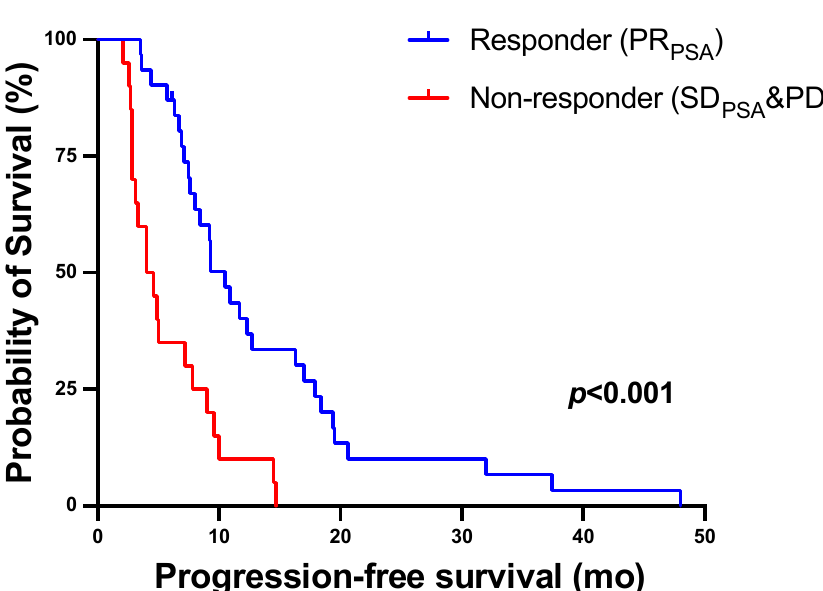
Figure 5. Kaplan–Meier curves for PFS stratified by biochemical response using serum PSA change after two cycles of 177 Lu-PSMA-617 RLT.